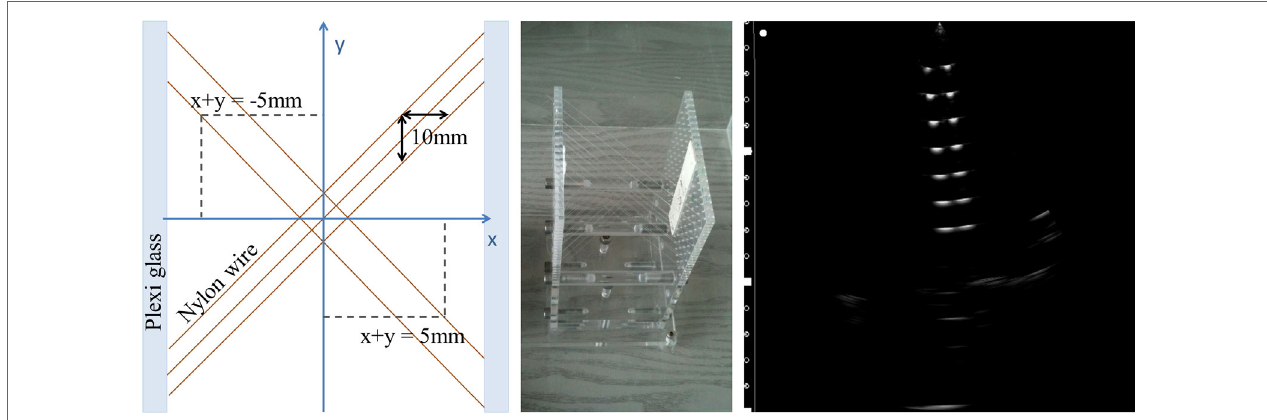
FigUre 2 | The multi-cross wire water phantom . Schematic view from the top (left) and photograph (middle) as well as a typical ultrasound scan of the wire construction imaged from the top